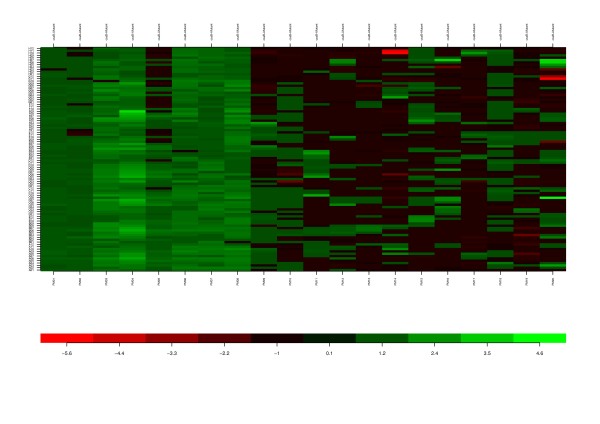
Heat map of cell growth changes for AP50c mutant. The heat map provides an overall picture of the cell growth impact on the 1,920 phenotypes for AP50c mutant strain as compared to the wild type strain. The green shaded areas (PM01-PM08) indicate better cell growth of mutant strain whereas the black and darkly shaded areas (PM09-PM20) indicate relatively similar cell growth of the mutant strain as compared to the wild type strain. The PM1 through PM20 data are presented as blocks of 20 columns. The rows represent the 96 wells in each of the PM plates (A01 through H12). The bar at the bottom provides visualization of the fold change between the mutant and the wild type parent strains.